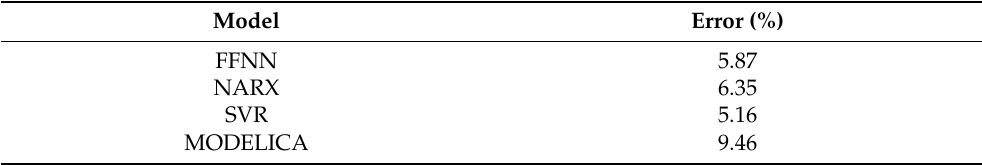
Figure 15. ( a )Percentage distribution error for the month of July by the FFNN model; ( b ) Percentage distribution error for the month of July by the NARX model; ( c ) Percentage distribution error for the month of July by the SVR model; ( d ) Percentage distribution error for the month of July by the analytical model. Table 8. Mean relative error of four models.